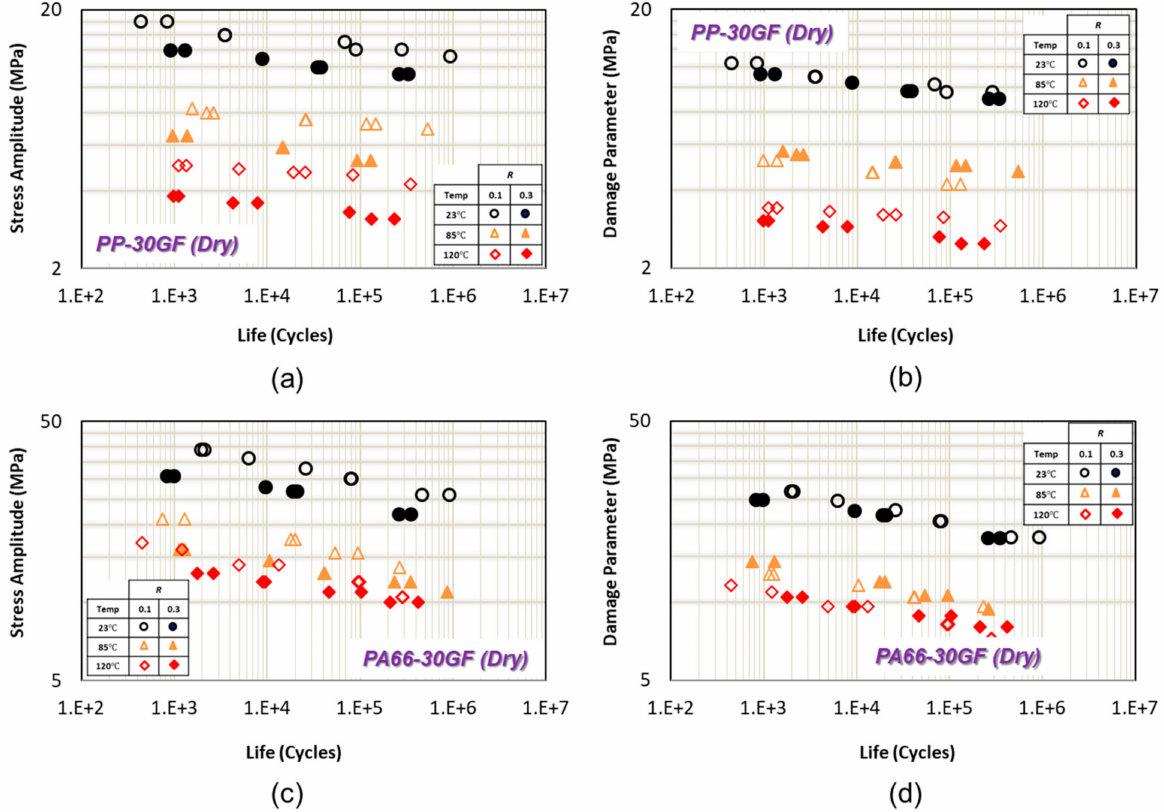
Figure 4. ( a ) Uniaxial fatigue data of PP-30GF in transverse direction from [15]. ( b ) Uniaxial fatigue data correlations of PP-30GF using the proposed damage parameter in transverse direction. ( c ) Uniaxial fatigue data of PA66-30GF in transverse direction from [15]. ( d ) Uniaxial fatigue data correlations of PA66-30GF using the proposed damage parameter in transverse